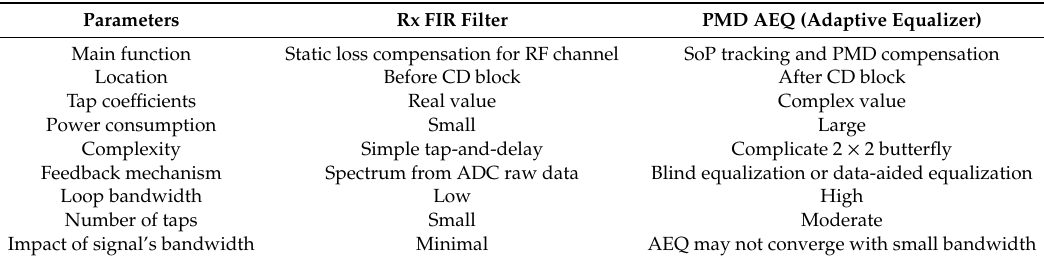
Table 1. Comparison between Rx FIR filter and PMD adaptive